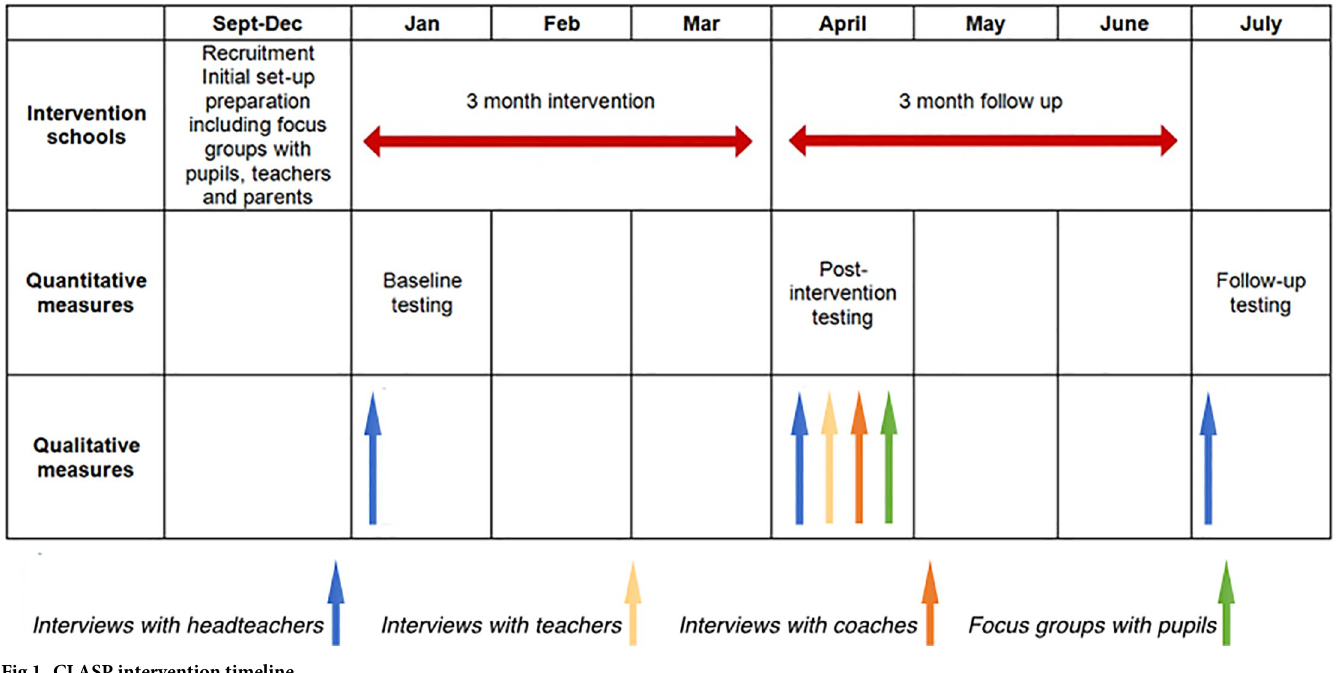
Fig 1. CLASP intervention